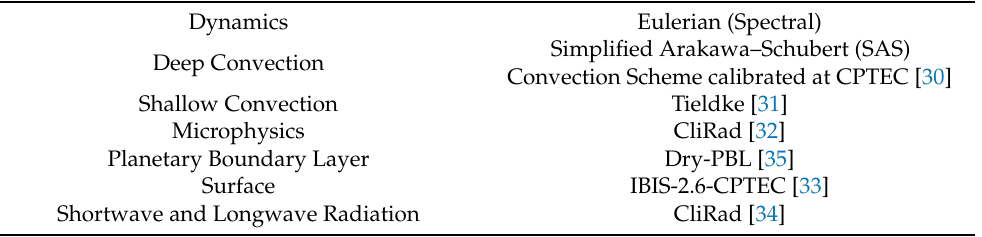
Table 1. BAM model